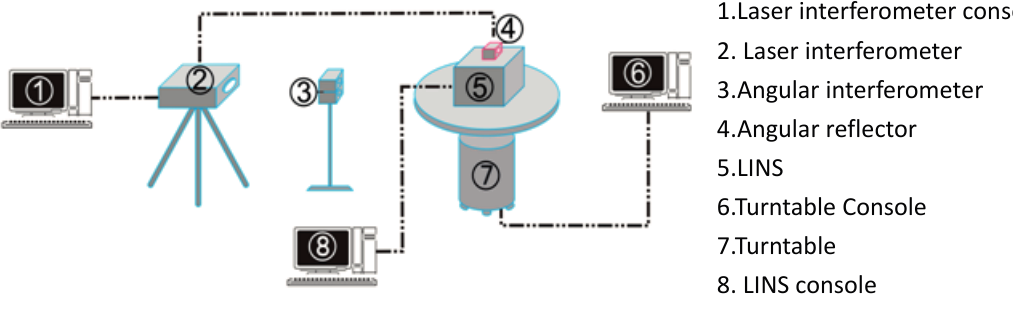
Figure 9. Connection of synchronization mechanism verification